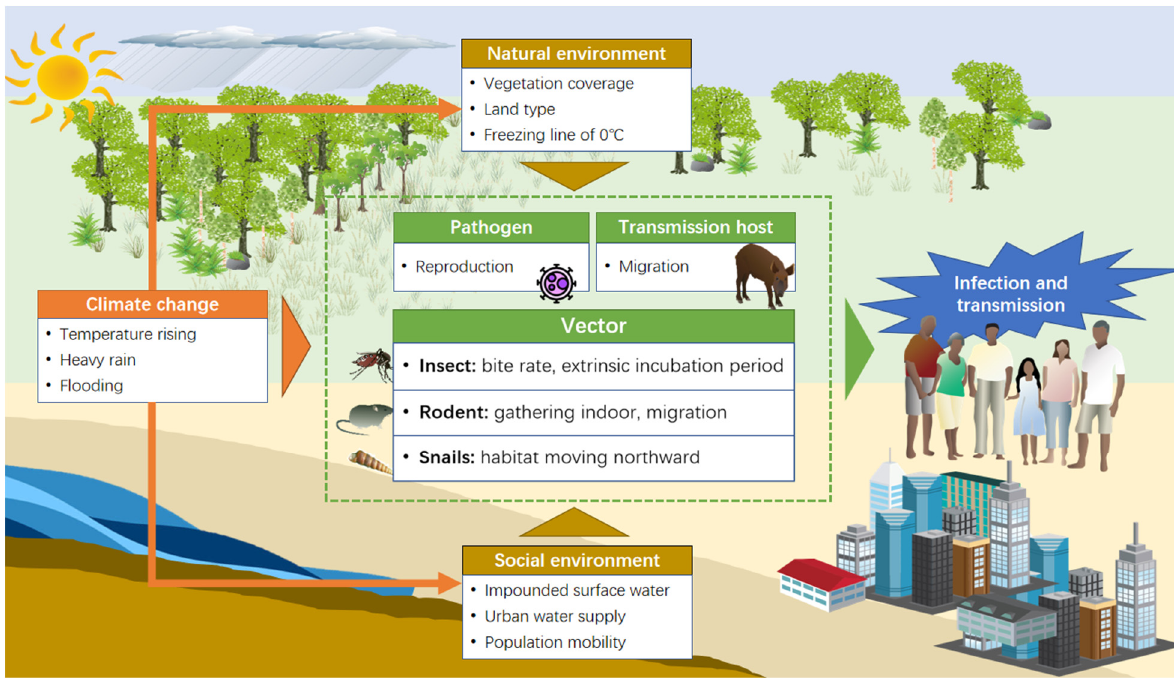
Figure 3. The main pathway of climate change impact on the risk of vector-borne diseases.